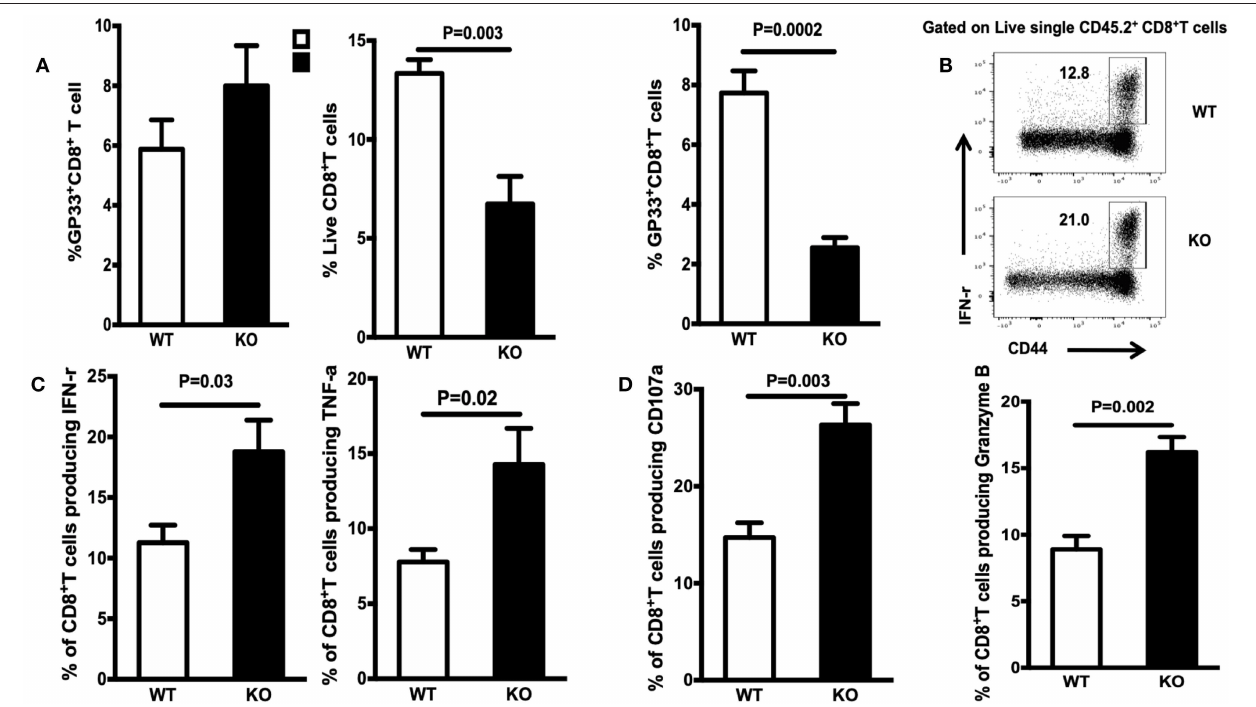
FIGURE 9 | WASp regulates CD8 + T cell memory via T cell-intrinsic mechanisms. Bone marrow (BM) cells from WT (CD45.2) or WASp − / − mice (CD45.2), and BM cells from WT (CD45.1) mice were mixed and adoptively transferred (intravenously at a 1:1 ratio) into lethally irradiated WT (CD45.1) mice. After reconstitution for at least 8 weeks, chimeric mice were infected with LCMV. Analysis was performed on Days 8 and 60 PI. All flow cytometry plots are gated on live CD45.2 + CD8 + T cells (except A, middle panel, which was gated on live CD45.2 + cells). (A) Left panel: percentage of GP33-specific T cells within CD8 in chimeric mice on D8; middle and right panels, percentage of CD8 in lymphocytes and GP33-specific T cells within the CD8 + T cell population in chimeric mice on D60 PI. (B) Representative data showing the percentage of IFN- γ within CD8 + T cells in chimeric mice on D60 PI. (C) Percentage of IFN- γ - or TNF- α -producing cells within CD8 + T cells in chimeric mice on D60 PI. (D) Percentage of CD107 α - or Granzyme B-producing T cells within CD8 + T cells in chimeric mice on D60 PI. Data are expressed as the mean ± SEM ( n = 5 mice per group) and were analyzed using an unpaired t